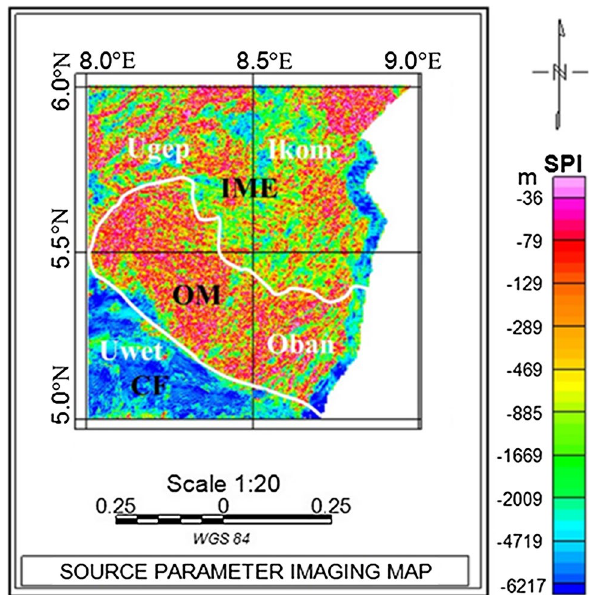
Fig. 11 Source parameter imaging map of the study